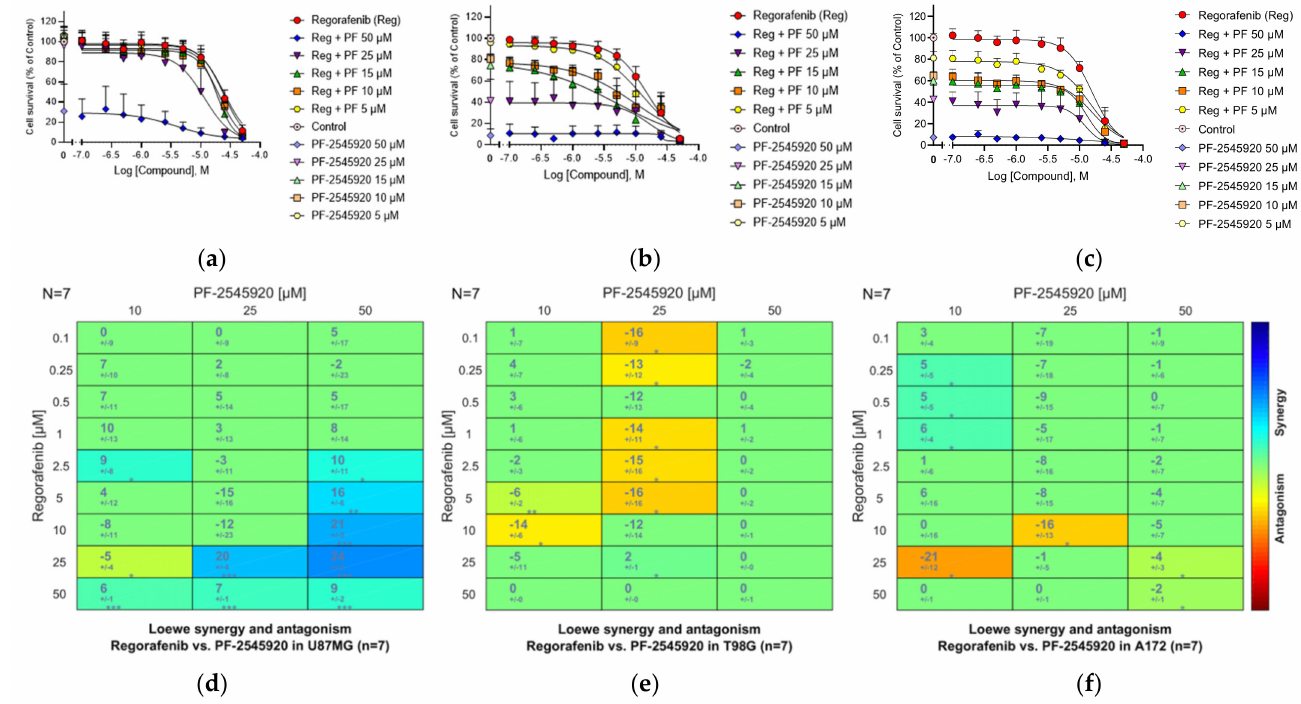
Figure 7. Anti-proliferative effect of combining Mardepodect and Regorafenib; ( a ) U87MG; ( b ) A172; ( c ) T98G cells. Data are presented as the mean ± standard error of the mean (SEM) ( n = 7); ( d – f ), corresponding quantitative analyses of the same data using the Loewe method. Synergy is seen in U87MG cells, but antagonism in both T98G and A172 cells. Note: asterisks indicate the significance of synergy scores obtained following a one-sample t -test (* p < 0.05; ** p < 0.001; *** p <